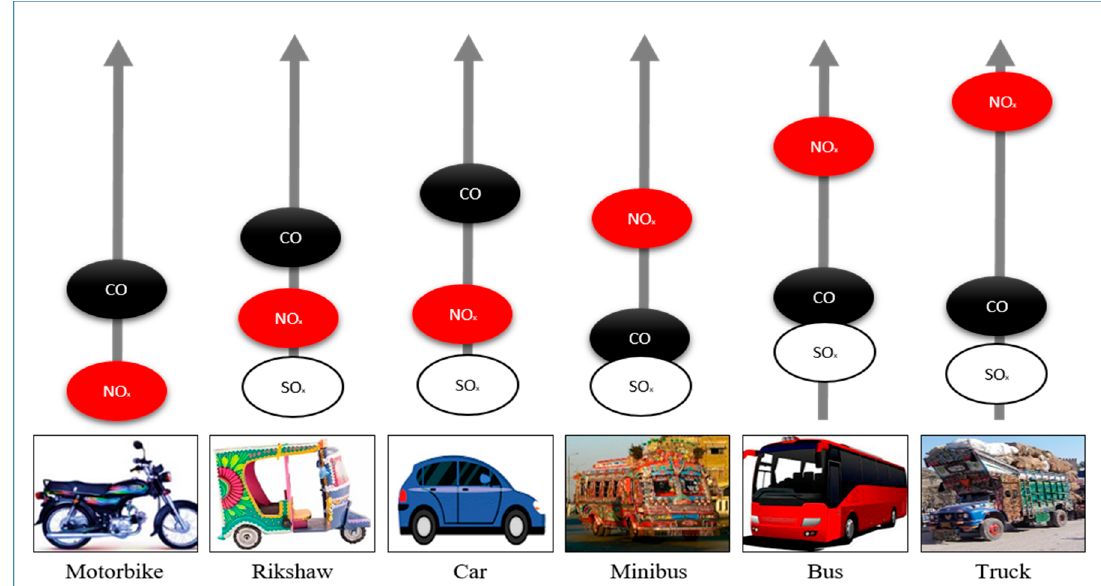
Figure 6. The comparative contribution of pollutants based on vehicle type.